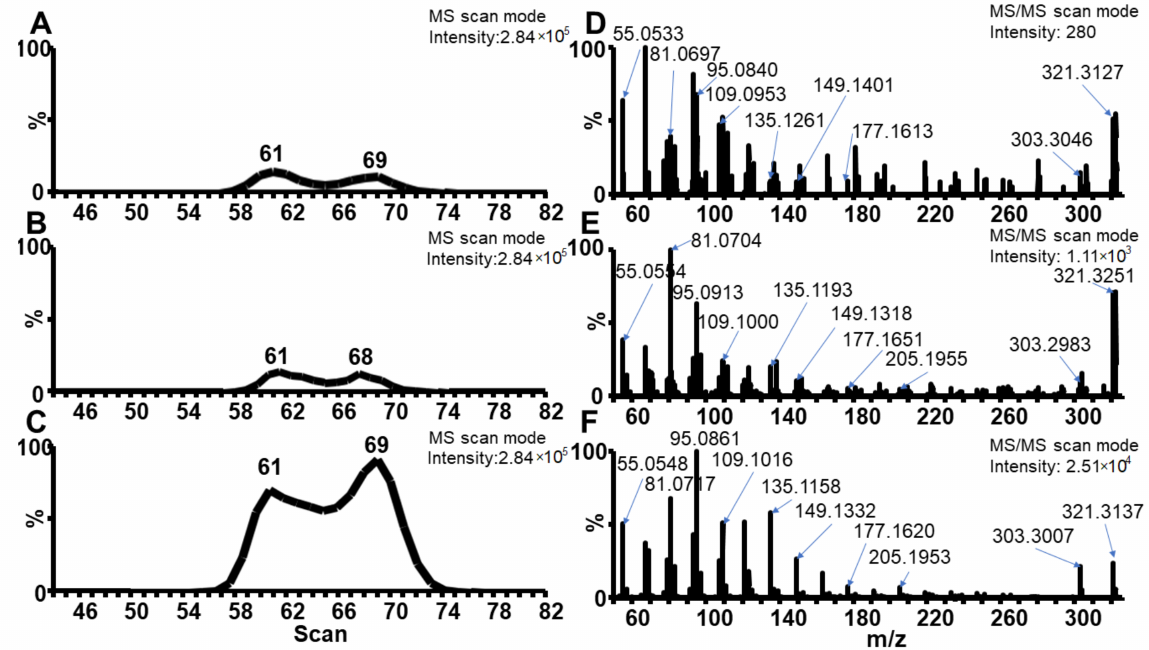
Figure 3. ASAP-IMS-HRMS extracted ion mobilograms ( A – C ) and ASAP-IM-MS/MS fragmentation spectra for m / z 321.316 ( D – F ), i.e., detected in mold #1 ( A , D ), mold #2 ( B , E ) and ceresin standard ( C , F